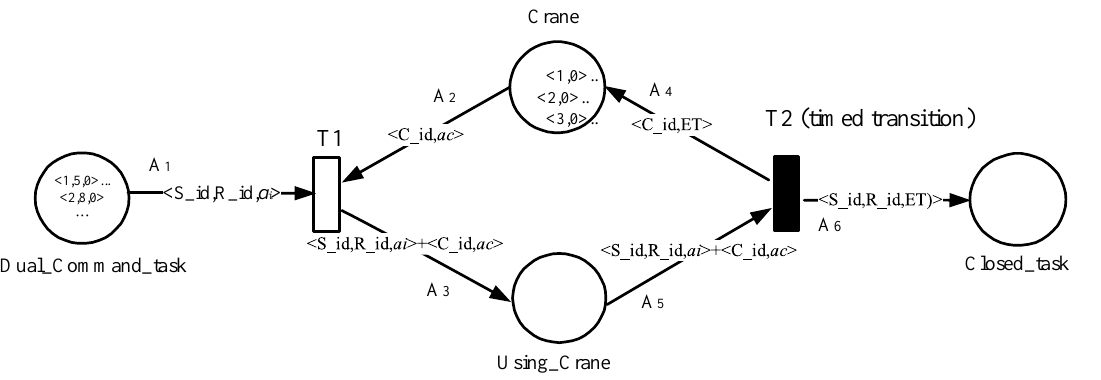
Figure 12. A discrete-event simulation model of timed predicate/transition net.